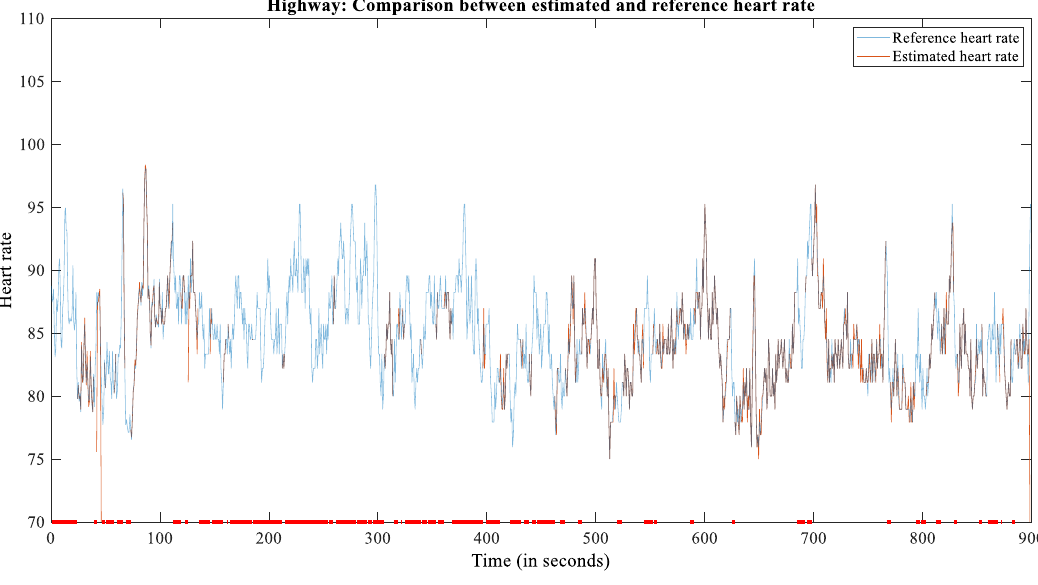
Figure 6. The plot of reference and estimated HR for subject 2209 during the city scenario.